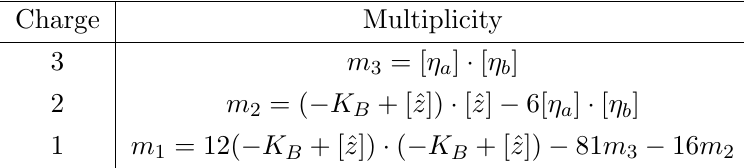
Table 3 . Charged matter multiplicities for the q = 3